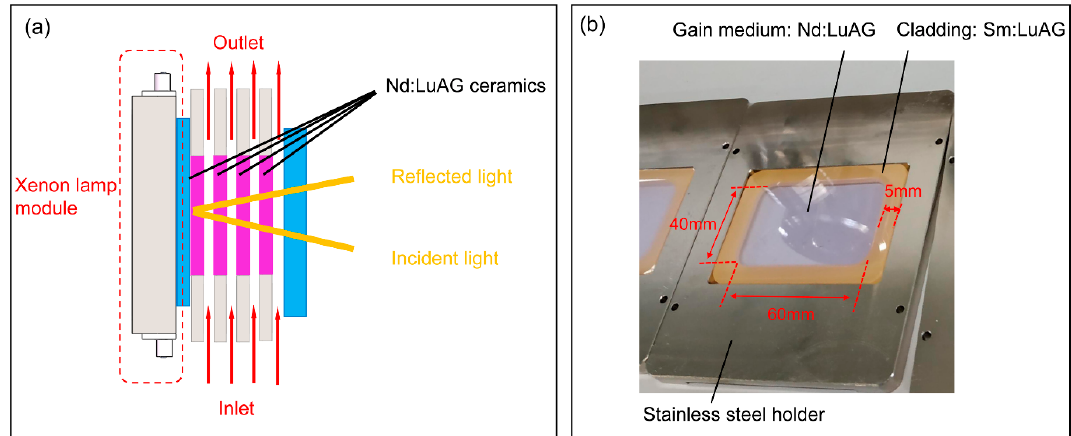
Figure 2. ( a ) Schematic diagram of the direct-liquid-cooled split-disk laser amplifier; ( b ) picture of Nd: LuAG ceramics.